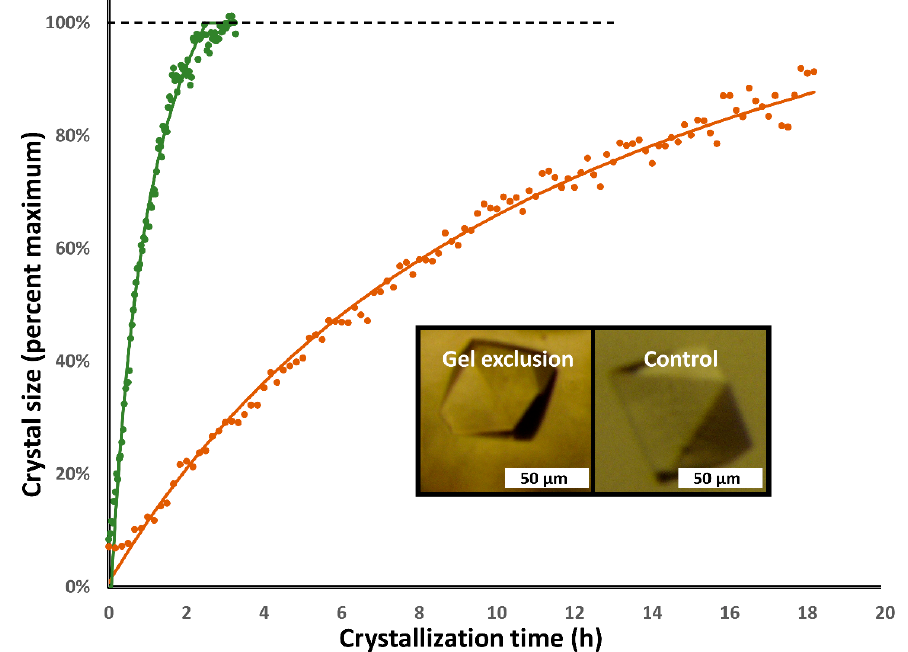
Figure 3. Growth rate for proteinase K crystals grown using gel exclusion (green) and conventional hanging drop (orange). Data are fitted by a single polynomial asymptotic curve with an upper bound that is lower than the asymptotic value. Crystal habits were virtually identical (inset).